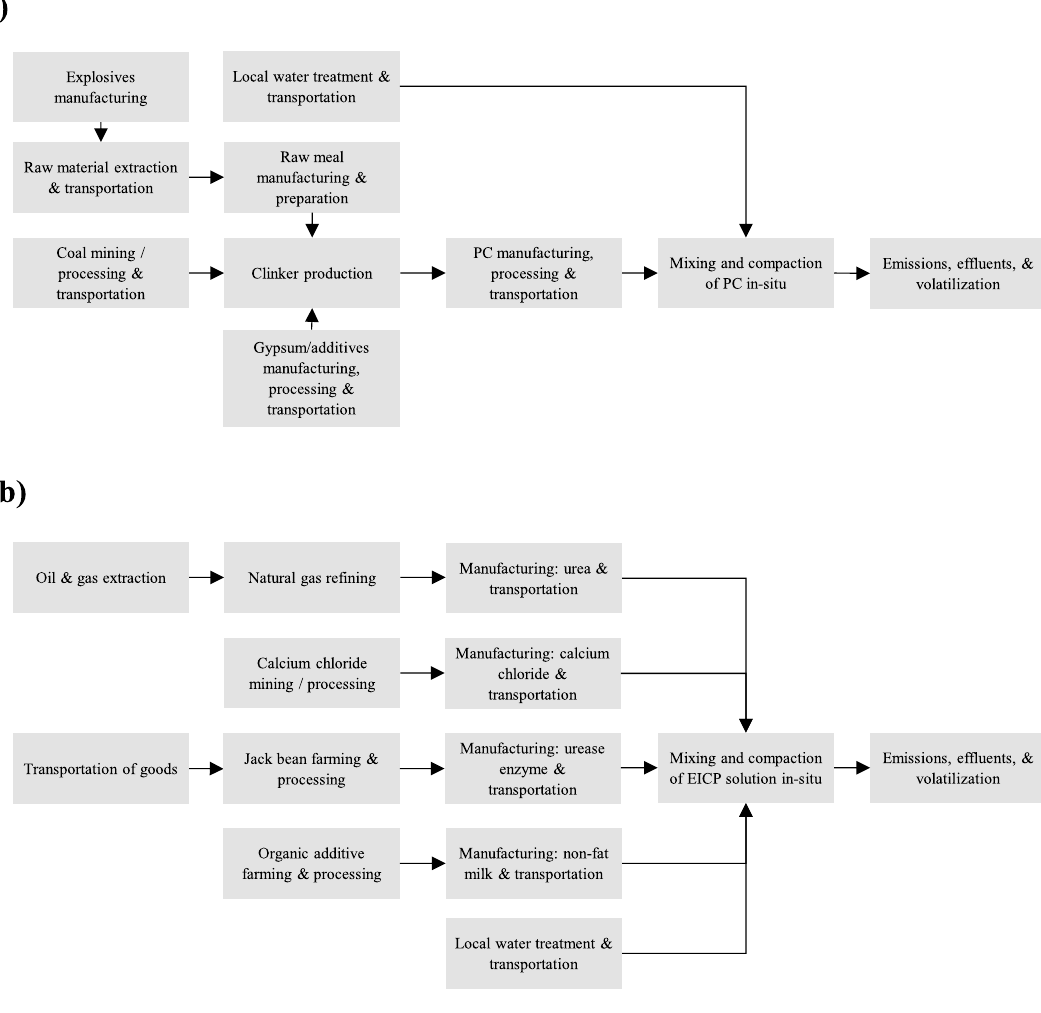
Figure 1. Definition of system boundary for the ( a ) PC and ( b ) EICP soil stabilization techniques.